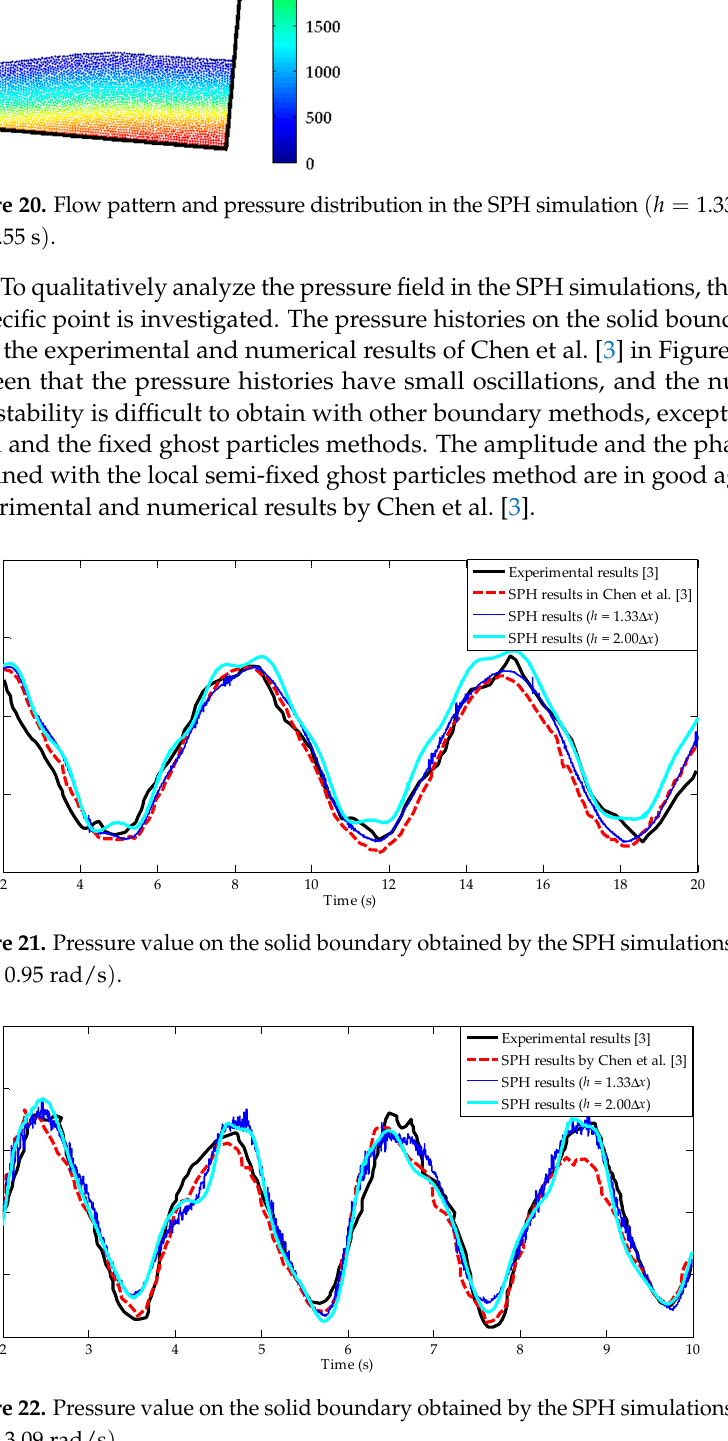
15 of 23 Figure 18. Flow pattern reproduced form the experiment of Chen et al. [3] (